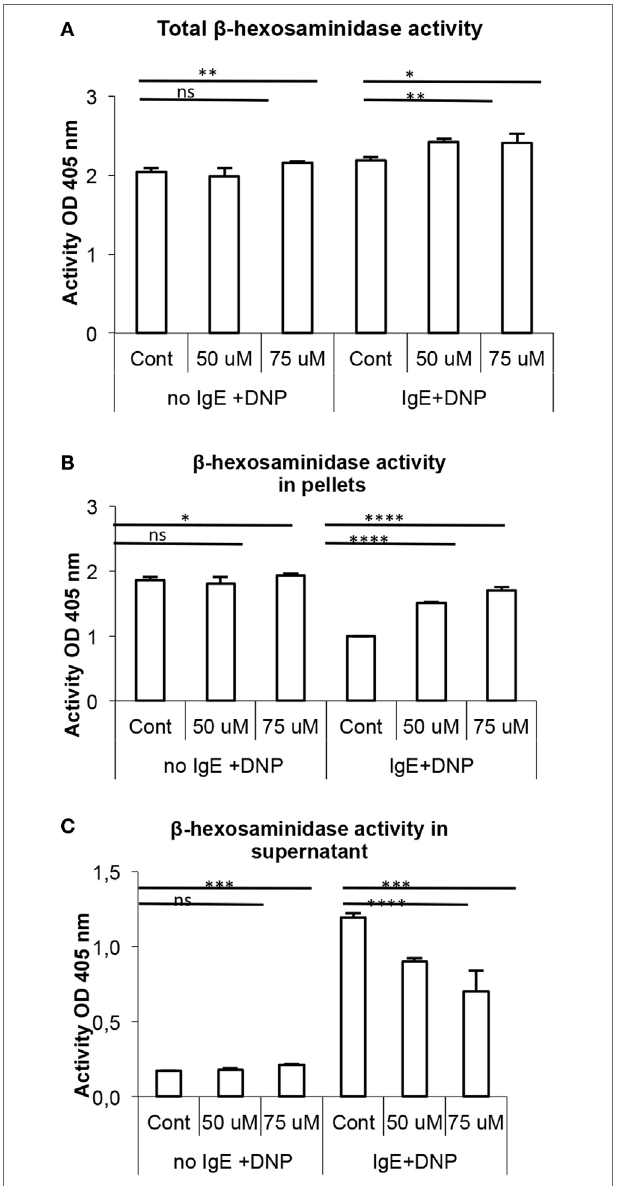
FigUre 7 | β -hexosaminidase storage is not affected by MEK1/2 inhibition. Bone marrow-derived mast cells (0.5–1.0 × 10 6 cells/mL) were incubated for 7 days with PD98059 (PD) at the indicated concentrations. Cells were either non-sensitized or sensitized with anti-DNP IgE as indicated, followed by addition of DNP-HSA to induce IgE receptor crosslinking leading to degranulation. Cells were assayed for total β -hexosaminidase (a) , as well as for β -hexosaminidase activity in the supernatant (B) and in the residual cell pellets (c) (* p ≤ 0.05, ** p ≤ 0.01, *** p ≤ 0.001, **** p ≤ 0.0001) (n =